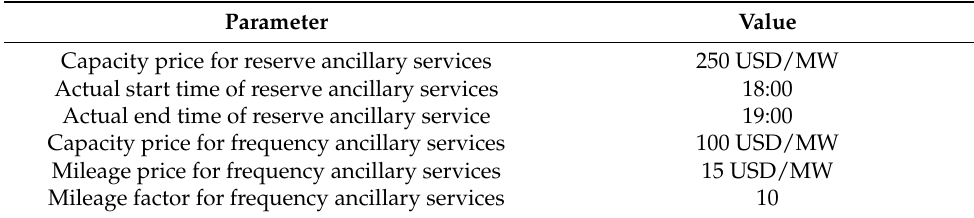
Table 2. Ancillary service